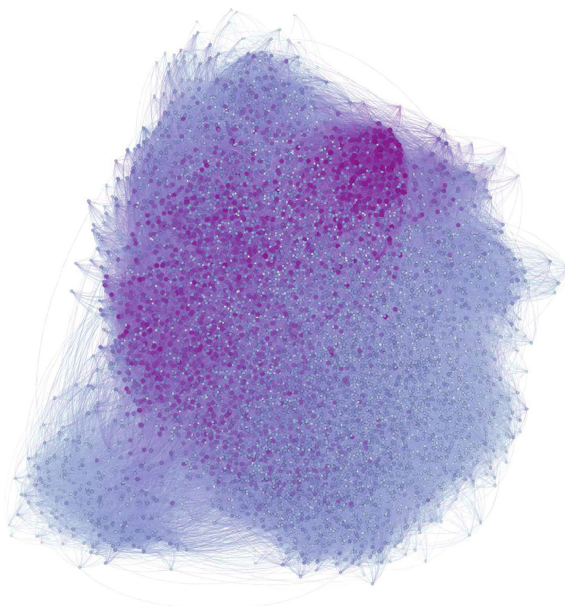
Figure 2: User relationship network of social network based on